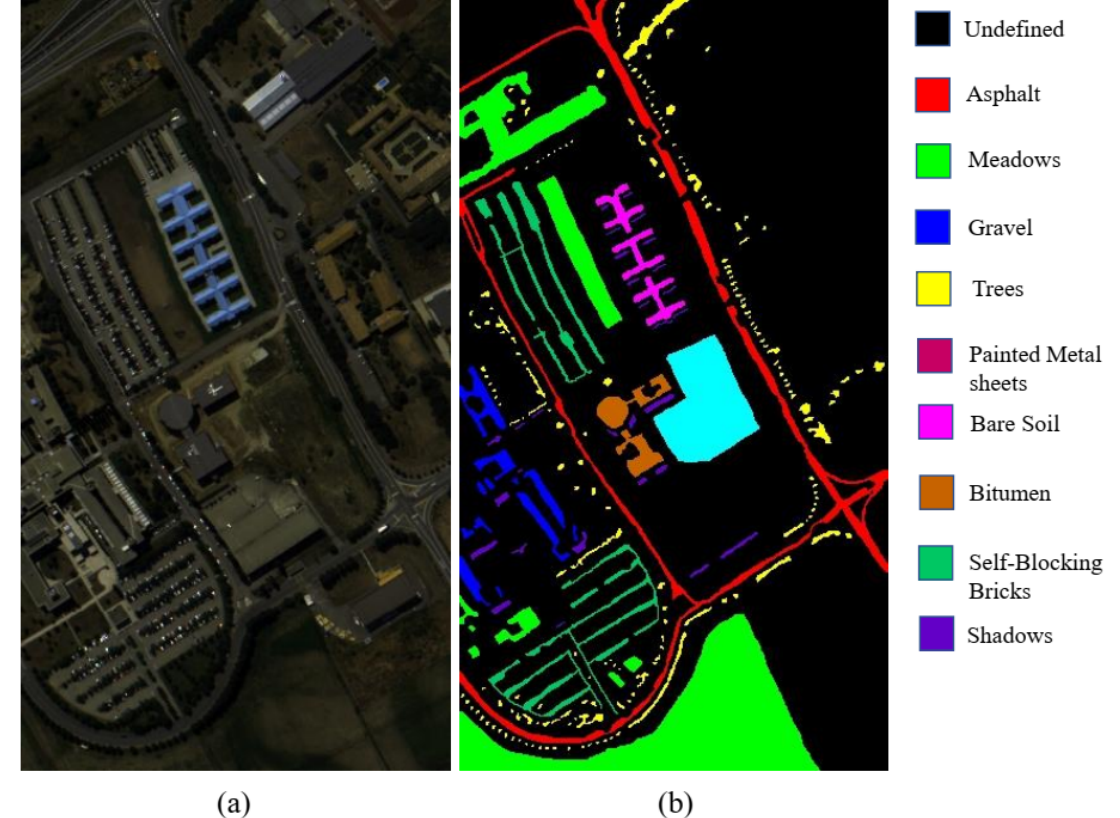
Figure 5. University of Pavia dataset. ( a ) False-color image; ( b ) Ground Truth. Table 3. Training and Test Samples for UP.